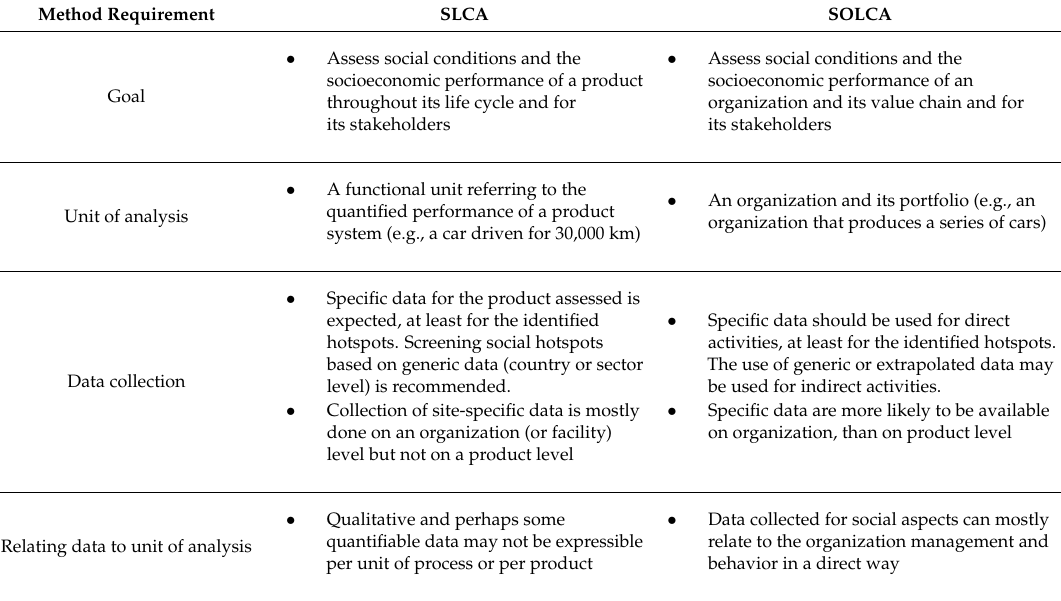
Table 1. Summary of key differences between the SLCA and SOLCA framework, adapted from